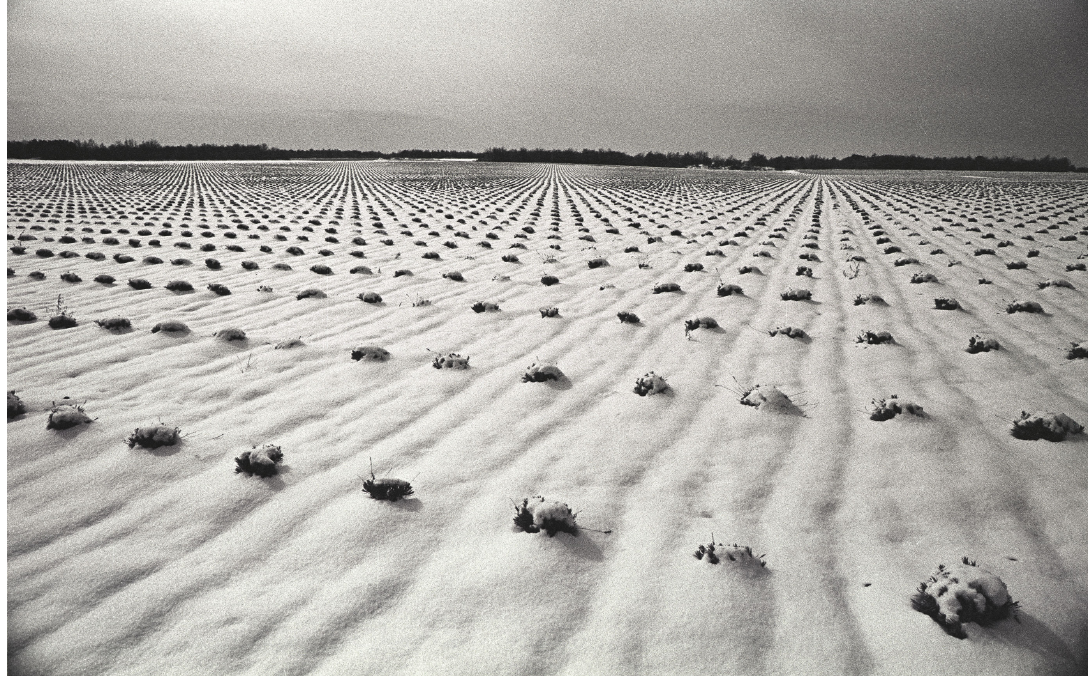
Figure 5. Vanishing points on horizon. Field of lavender plants, Valensole plateau, Alpes-de-Haute- Provence, France. Photo by François Rouvière in [28] (Figure 20, p. 211) c (cid:13) EDP